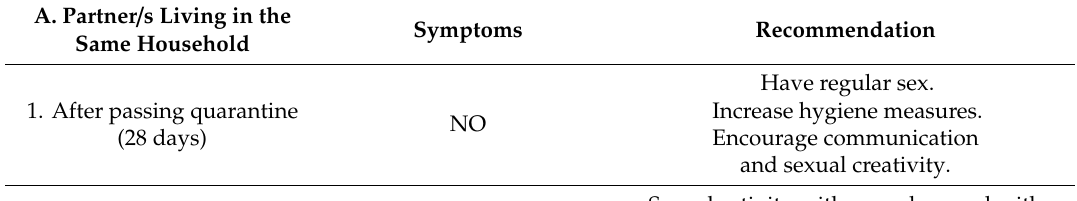
Table 1. Summary of recommendations for sexual activity during the COVID-19